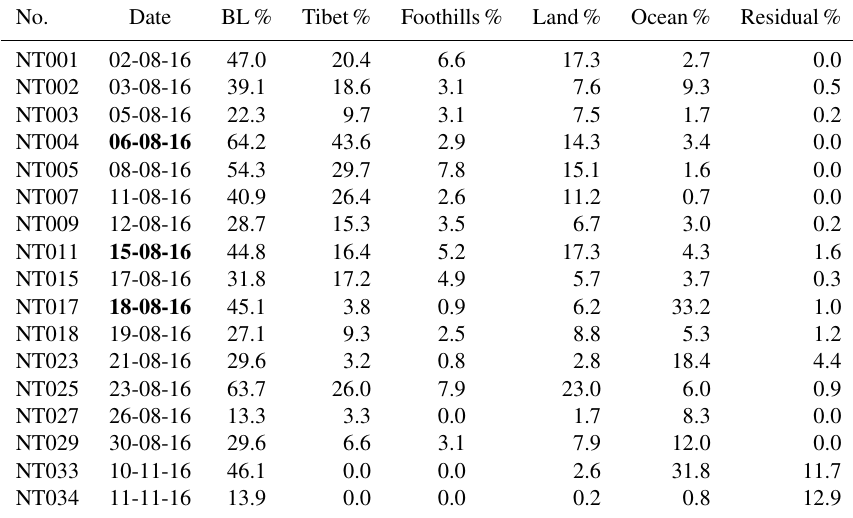
Table 4. Same as Table 3 but for the location of the strongest updraft along the 40-day backward trajectories ending in the BL. The strongest updraft is calculated by the maximum change in potential temperature within a time period of 18h along the trajectories. The location of the maximum updraft within 18h is then calculated as the mean location of the trajectory within 18h. The dates of three balloon flights representing typical situations encountered during the measurements in August 2016 are marked in bold type (see Table